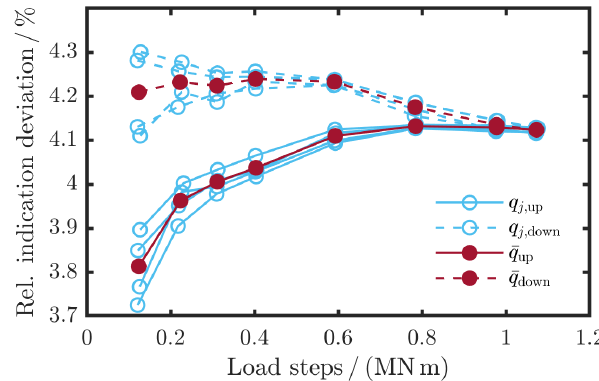
Figure 6. Relative indication deviation of the torque transducer in the WTTB as the result of the torque calibration under a constant rotation of n = 6 . 5min − 1